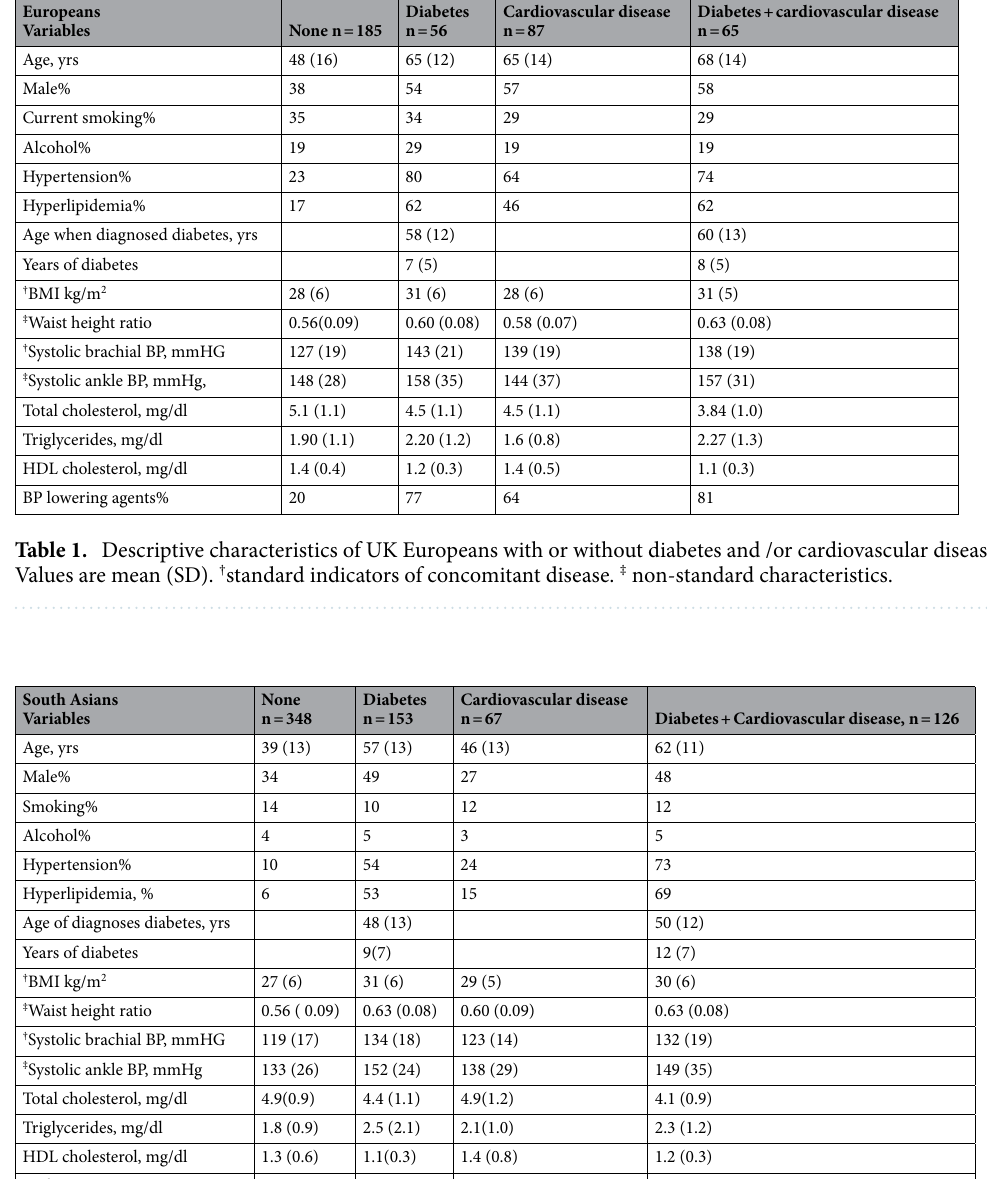
Table 2. Descriptive characteristics of South Asians with or without diabetes and /or cardiovascular diseases. Values are mean (SD). † Standard indicators of concomitant disease. ‡ Non-standard characteristics.